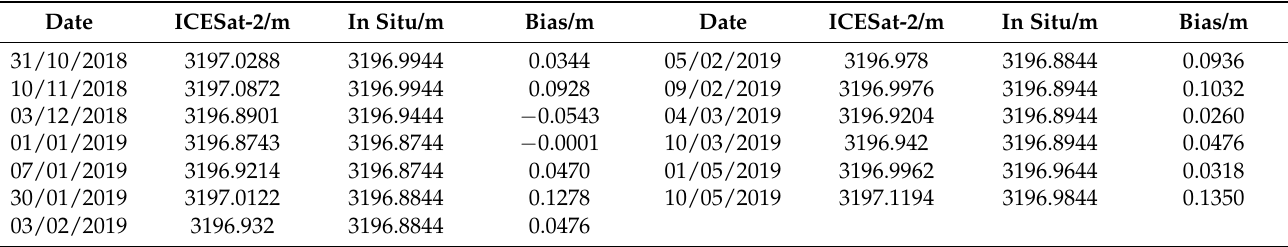
Table A4. The validation for ICESat-2, using the in situ